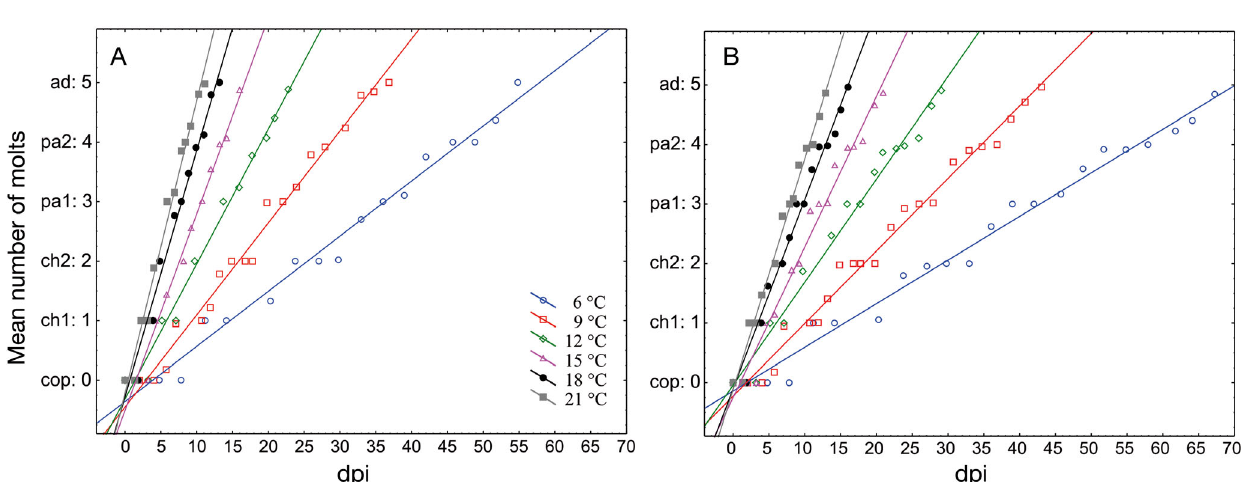
Fig. 2. Mean number of molts (MnM) vs. days post infection (dpi) for Lepeophtheirus salmonis (A) males and (B) females. Lines represent the predicted MnM as a function of dpi at each of the temperatures tested: MnM( T) = a + rM( T) dpi, where the mean